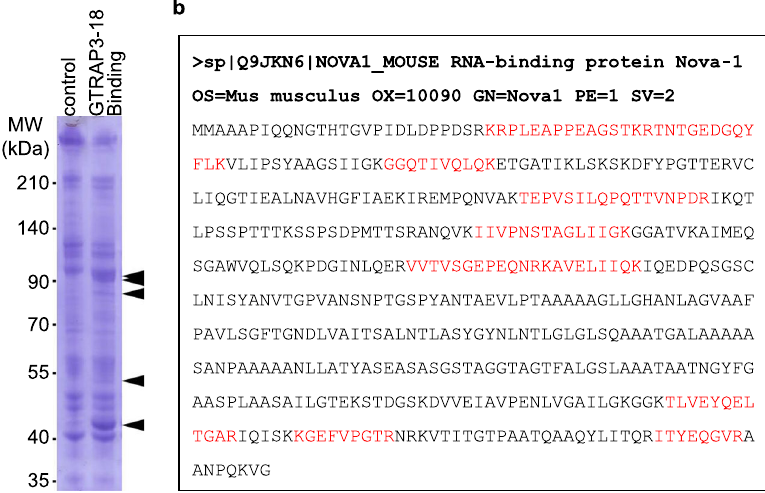
Fig. 2 Identi fi cation of the protein mediating the increase of GTRAP3-18 expression by miR-96-5p. a The binding protein samples extracted from the magnetic beads conjugated with GTRAP3-18 3 ′ -UTR RNA or scrambled RNA (control) were loaded on the SDS-PAGE gel. CBB stained gels are shown. Arrows indicate the bands analyzed by mass spectrometry. Molecular weight markers are depicted at left. The full-length gel is presented in Supplementary Fig. 13. b A result of mass spectrometry analysis of the puri fi ed protein with the matched amino acids is shown (red). List of the RBP candidates is presented in Supplementary Table